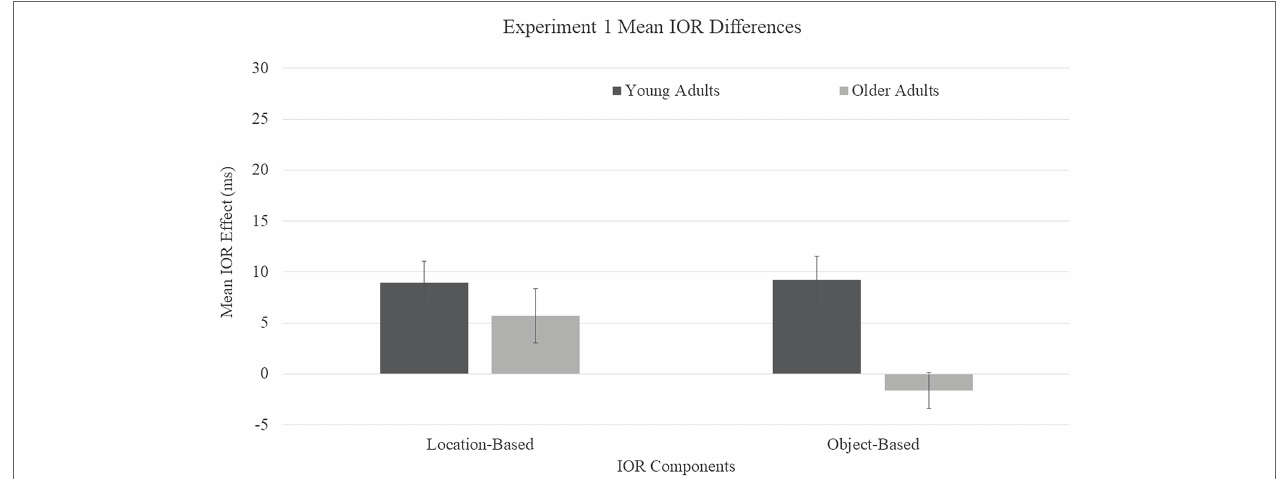
FIGURE 2 | Mean inhibition of return (IOR) difference scores for Experiment 1. Location-based IOR was calculated by subtracting the mean RT for cued-location subtracted by the mean RT for the uncued condition. Object-based IOR was calculated by subtracting the mean RT cued-object subtracted by the mean RT for the uncued location. Error bars represent one standard